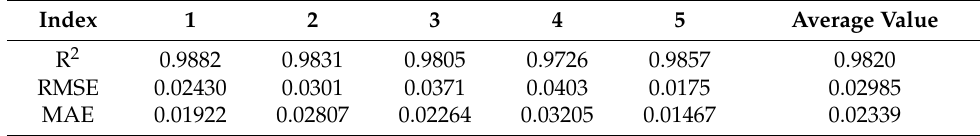
Figure 11. Optimal parameters results. ( a ) Parameter selection for sensitivity and ( b ) parameter selection for creep. Table 4. Value of the evaluation indices of the five-fold cross-validation for the SVR model on sensitivity.